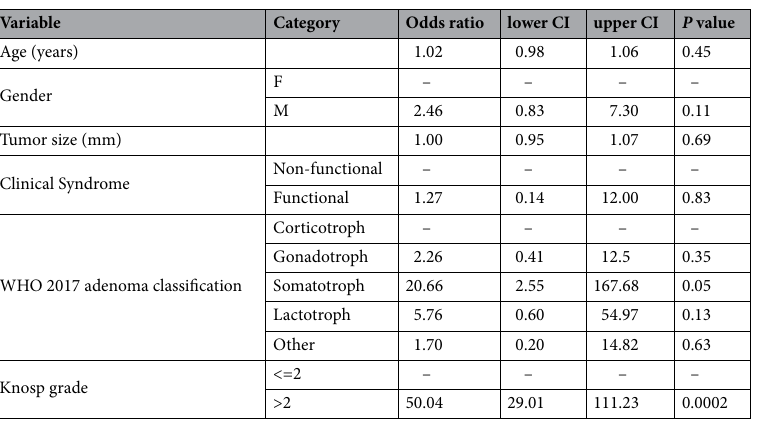
Table 3. Histological Medial Wall Invasion. Multivariate analysis of histological evaluation of invasion of the medial wall of the cavernous sinus to identify variables that influence invasion. Odds ratio, Confidence Intervals and p values area